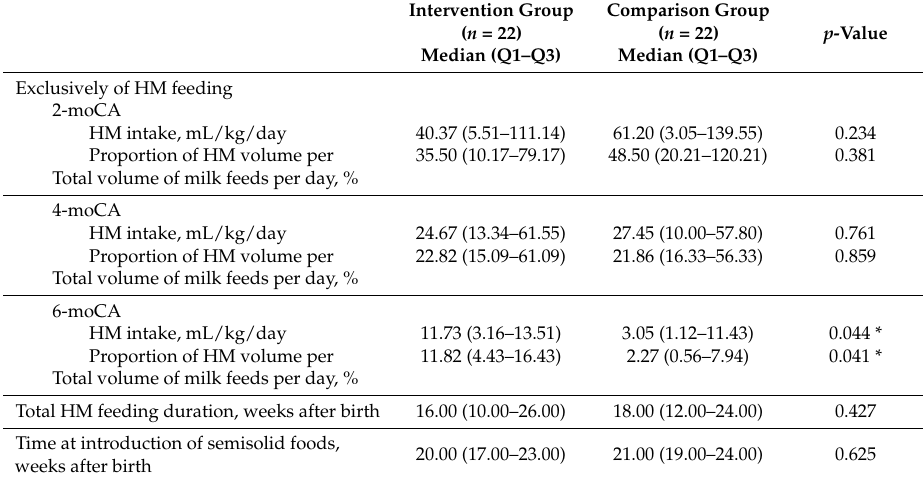
Table 5. Comparisons of exclusively human milk feeding, feeding duration and a timing of introducing semisolid foods between the groups.